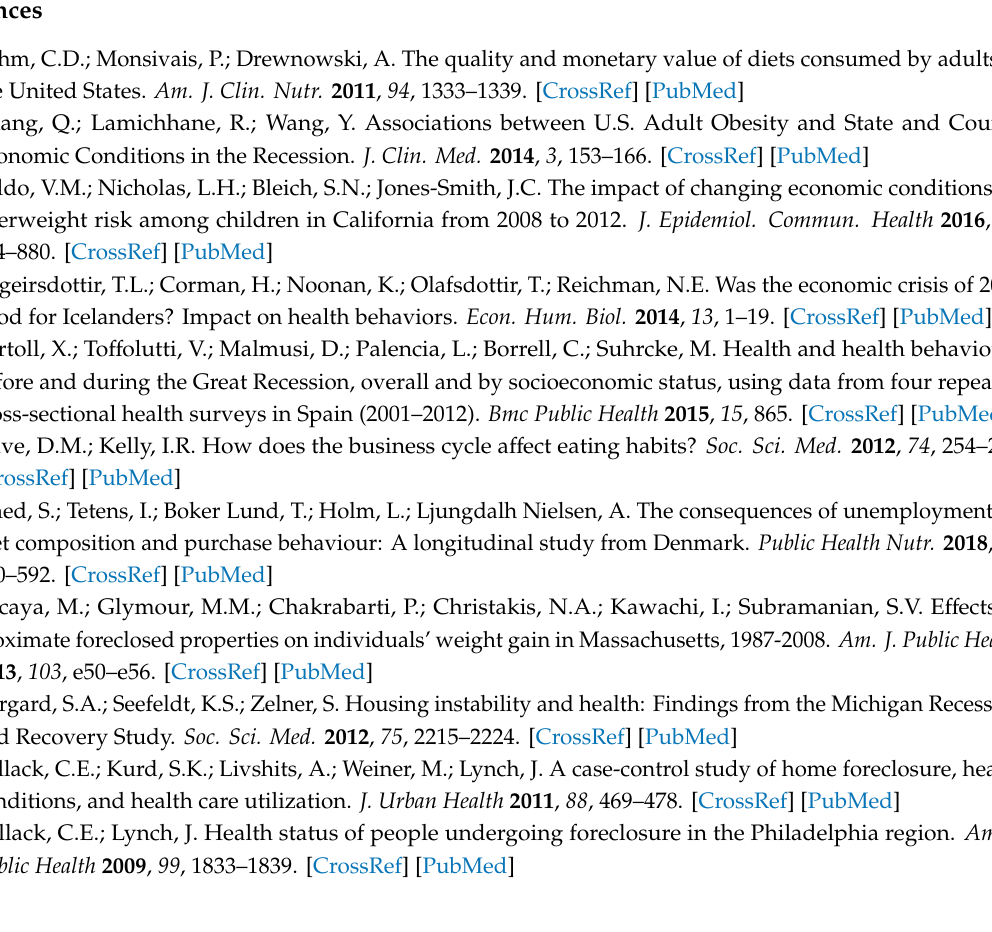
Table S1. Age di ff erential marginal e ff ects of housing value on four categories of food consumption, stratified by home ownership status; Table S2. Race di ff erential marginal e ff ects of housing value on four categories of food consumption, stratified by home ownership status; Table S3. Education di ff erential marginal e ff ects of housing value on four categories of food consumption, stratified by home ownership